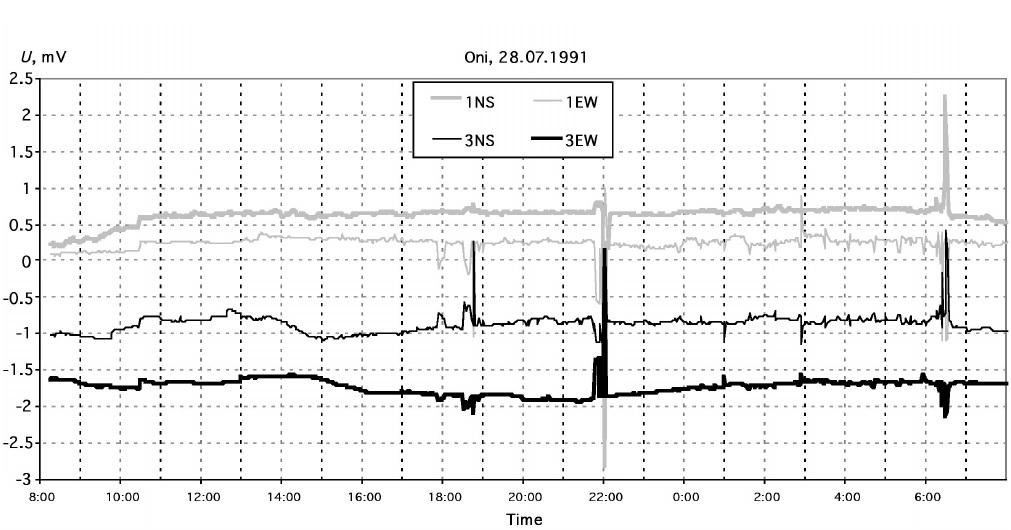
Fig. 3. Example of the records containing signals with steep fronts, which were registered at 1 and 3 points of measurement on 28.07.1991. The Arabic numbers designate the points of measurement. NS and EW specify di- rections of measuring lines.